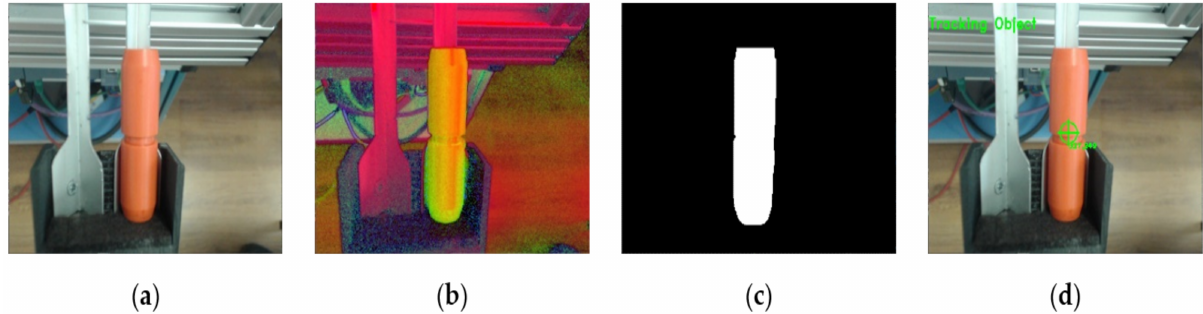
Figure 20. Object Detection with the following steps: ( a ) raw RGB image taken from the camera, ( b ) conversion from BGR to HSV ( c ) image segmentation after HSV limits are set, with morphological operations of erosion and dilation, ( d ) object is detected and the centroid is being